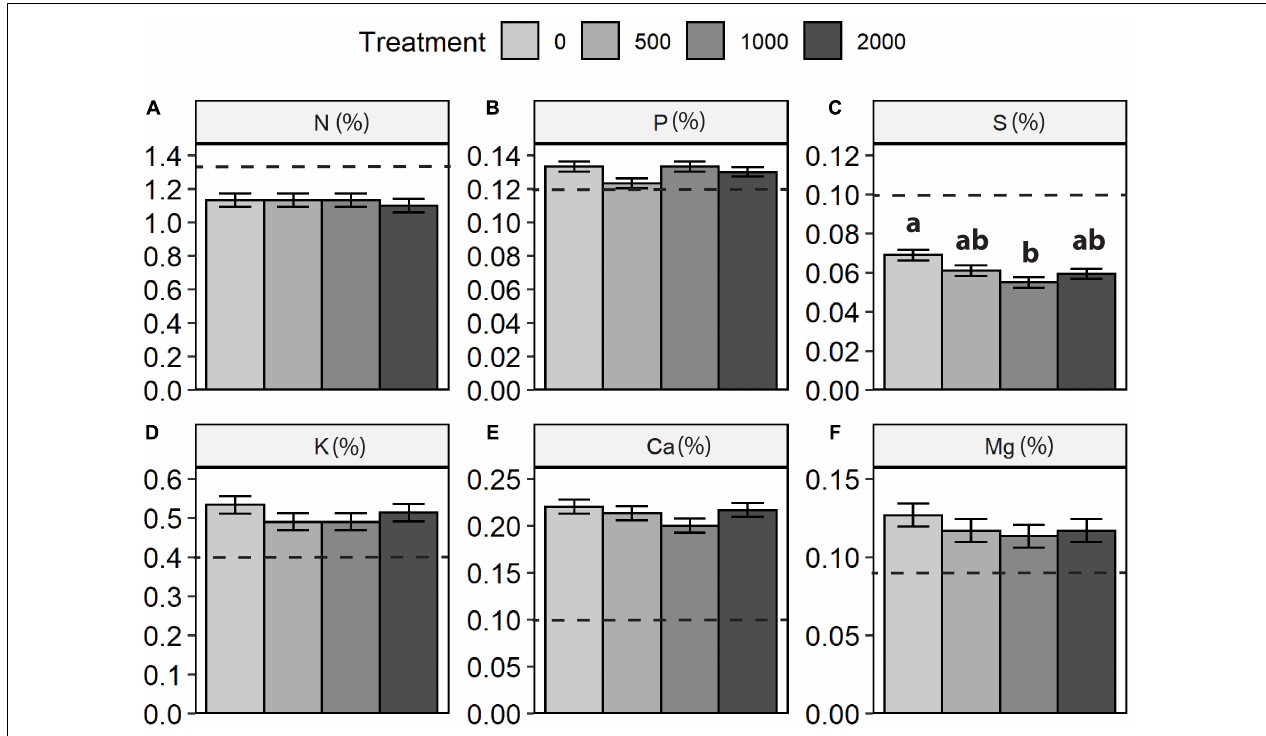
FIGURE 6 | Lodgepole pine foliar nutrient concentrations (2020): (A) nitrogen (N), (B) phosphorus (P), (C) sulphur (S), (D) potassium (K), (E) calcium (Ca), and (F) magnesium (Mg). Dashed horizontal lines indicate minimum adequate concentrations (Brockley, 2001). Where a significant treatment effect occurred ( Table 4 ), different letters (a, b) indicate significant differences between treatments ( p < 0.05).